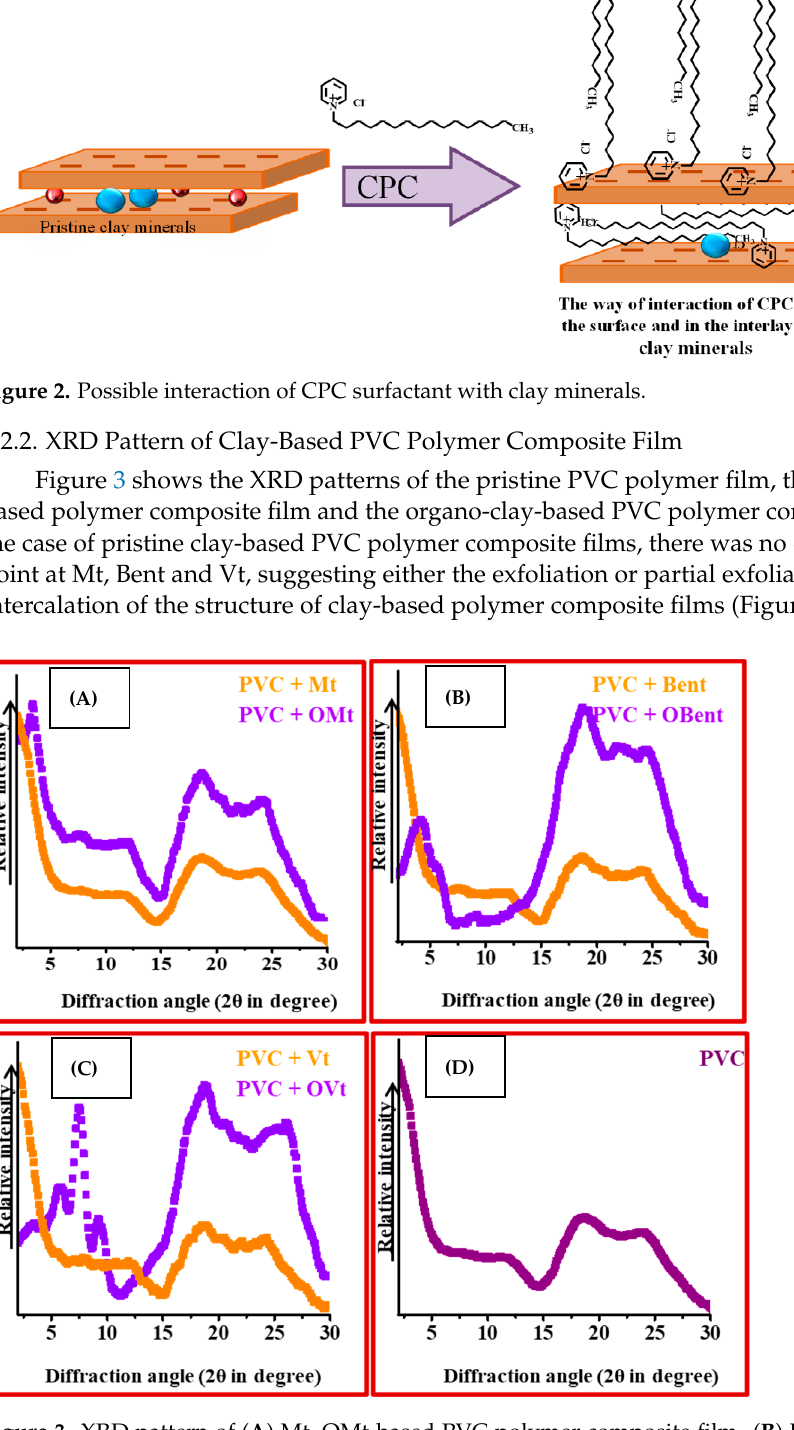
Figure 3. XRD pattern of ( A ) Mt, OMt-based PVC polymer composite film. ( B ) Bent, OBent PVC polymer composite film ( C ) Vt, OVt PVC polymer composite film. ( D ) Pure PVC polymer